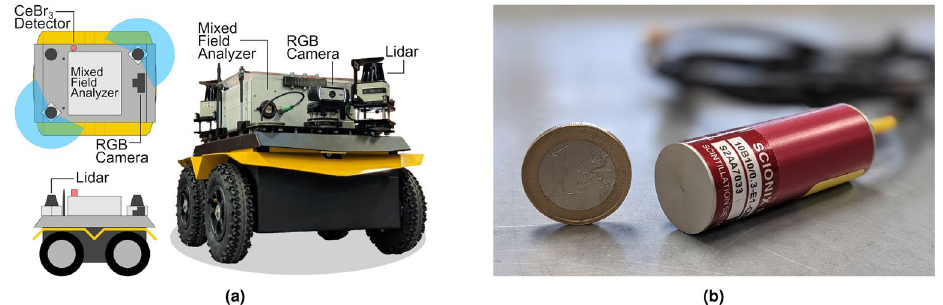
Figure 1. ( a ) Diagram and photograph of robot platform, consisting of a Clearpath Robotics Jackal UGV, front and rear 2D Lidar, forward facing RGB camera, and gamma radiation instrumentation (diagrams generated using Inkscape version 1.0.2 https:// inksc ape. org/ relea se/ inksc ape-1. 0.2/). ( b ) Photograph of the compact CeBr 3 scintillator detector used for this